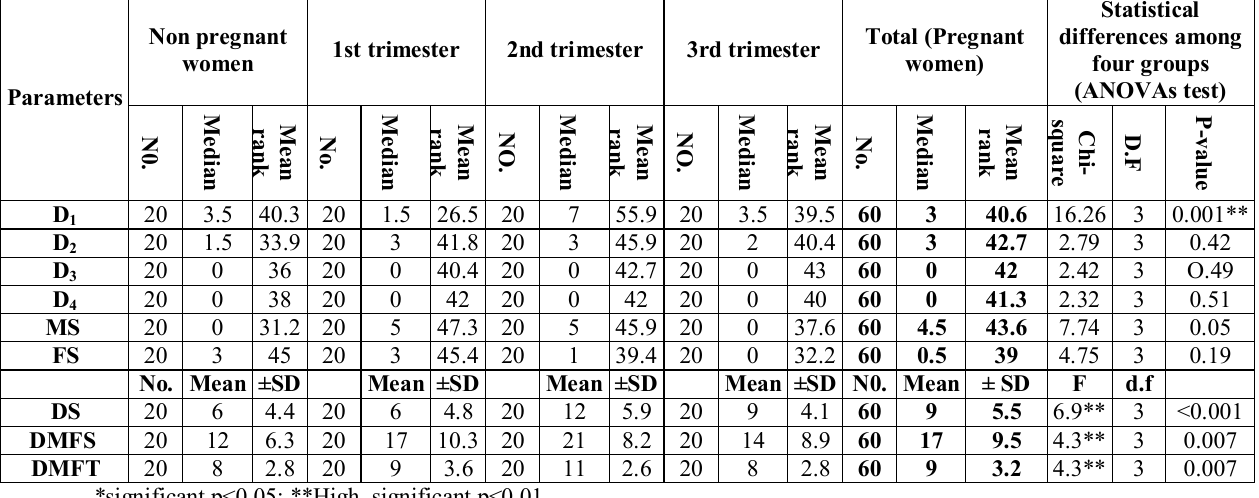
Table 1: Dental caries experience among non- pregnant and pregnant women according to trimester.